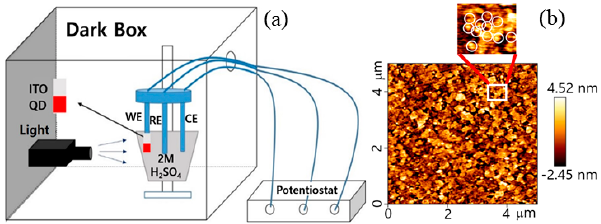
Figure 3. ( a ) A schematic showing the three-electrode configuration used for electrochemical measurements of QDs; ( b ) the arrays of QDs on the Indium Tin Oxide (ITO) electrode by AFM. Monolayered QDs are shown (one QD in a white circle, see the upper enlarged image).